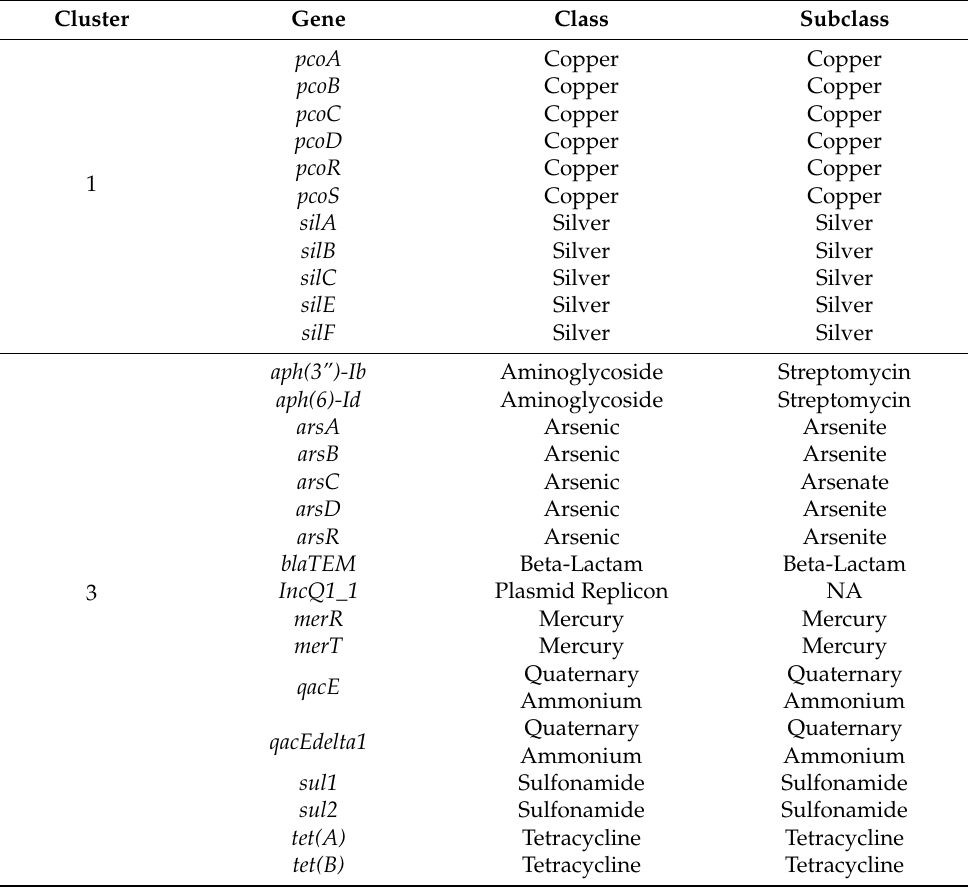
Table 2. Major groups of co-occurrent genes classified by k-means